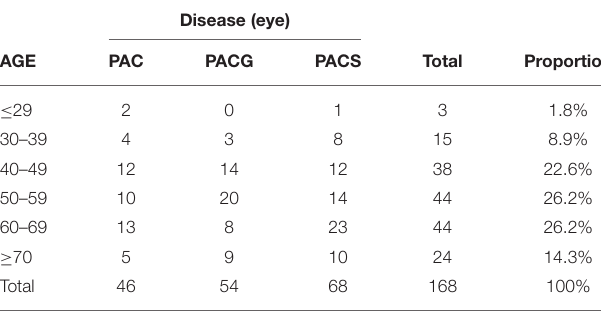
TABLE 1 | Demographic features of the population with cysts.